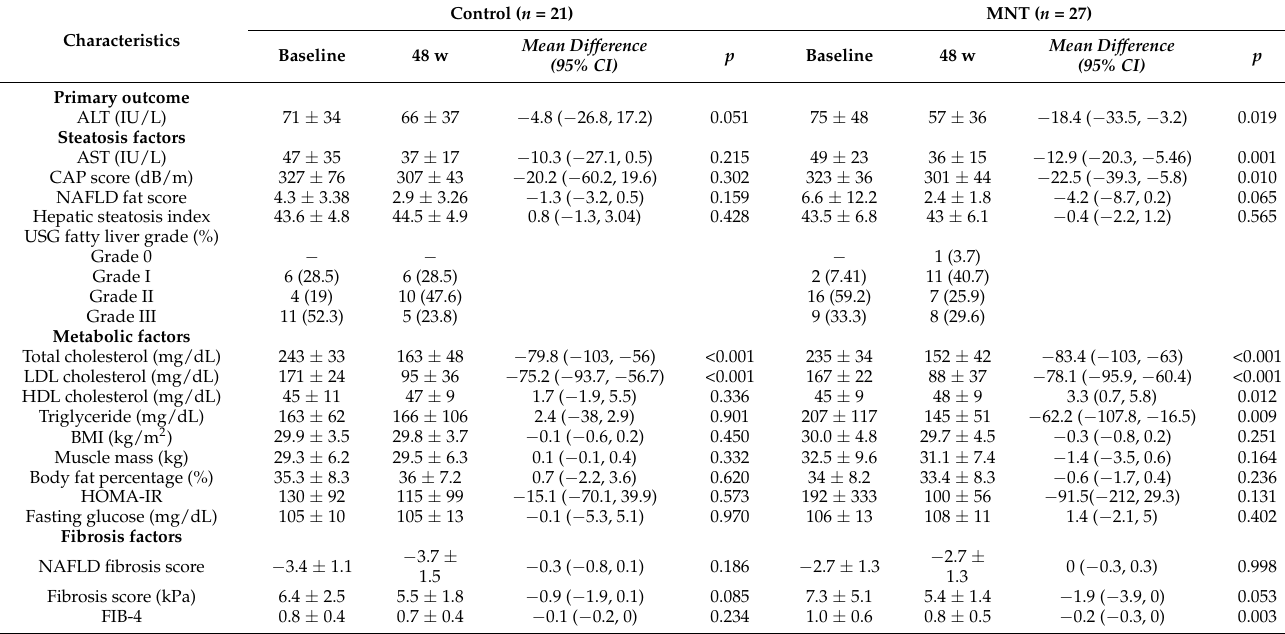
Table 2. Paired analysis in variables at 48 weeks compared to baseline within each